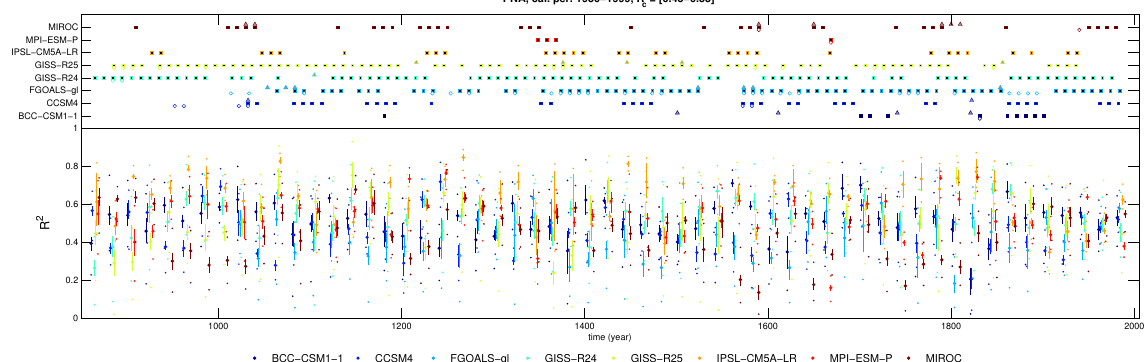
Figure 8. Skill metric ( R 2 ) for an ensemble of PNA reconstructions based on geophysical predictors from northwestern North America for subsequent 30-year periods (paced at 3-decade intervals). To be comparable with TT2010, only the subset of reconstructions with R 2 for the 1950–1999 calibration period in the range of 0.45–0.55 are shown, as for Fig. 7a. For each 30-year period, dots are minimum, mean and maximum of R 2 values, vertical lines indicate the inter-quartile interval of R 2 values. The top symbols indicate 30-year periods when the R 2 value for NPI (square), SOI (triangle) or NAO (circle) is, for at least one predictor set, better than the worst PNA value.